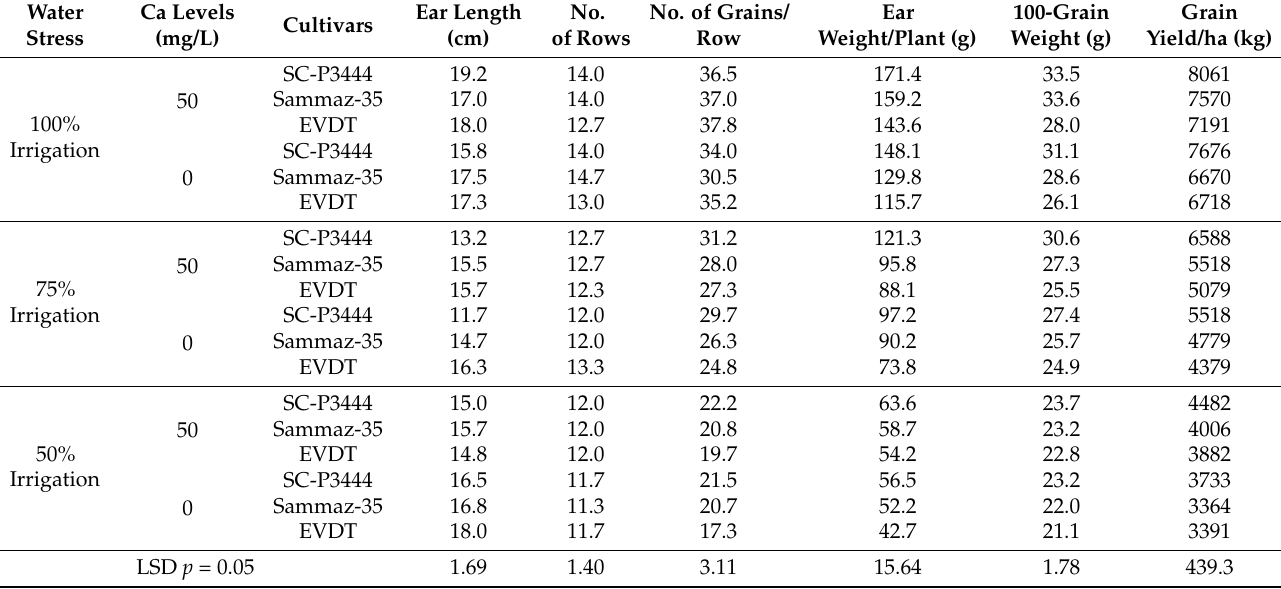
Table 5. Agronomic characteristics of three maize cultivars at different levels of irrigation and foliar application of Ca. Water